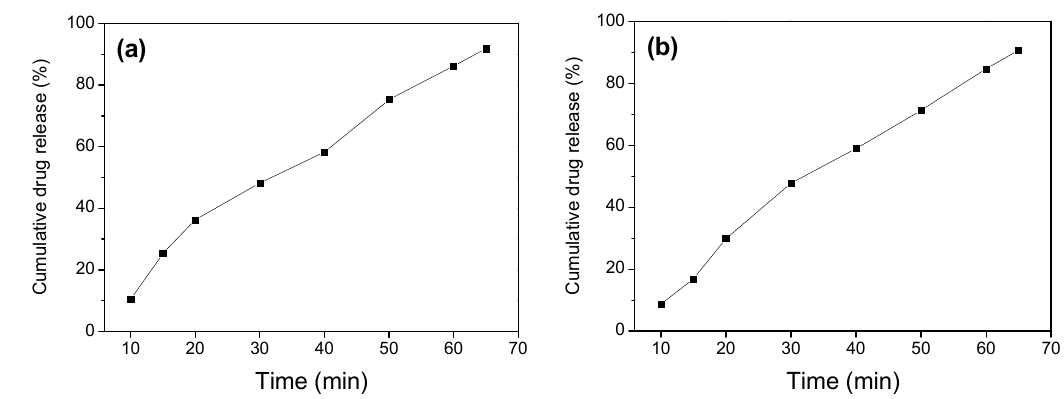
Figure 8. Drug release curves of ( a ) Fe 3 O 4 /SiO 2 core-shell composite nanospheres and ( b ) Fe 3 O 4 /SiO 2 /PPy core-shell composite nanospheres under ultrasonication. The sustained release kinetic curves and the kinetic model parameters of Fe 3 O 4 /SiO 2 and Fe 3 O 4 /SiO 2 /PPy core-shell composite nanospheres under ultrasonication are shown in Figure 9 and Table 3. It can be seen that the two release systems had the release exponent value n = 0.9008 and 0.9907, respectively. The magnitude of release exponent indicates that the kinetic release mechanism was non-Fick diffusion [36].